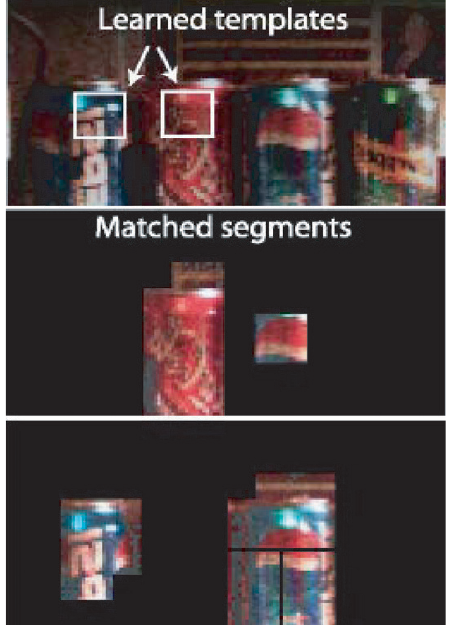
Figure 15: Function of the complete chip: images acquired by the array, learned templates, and locations of matches.